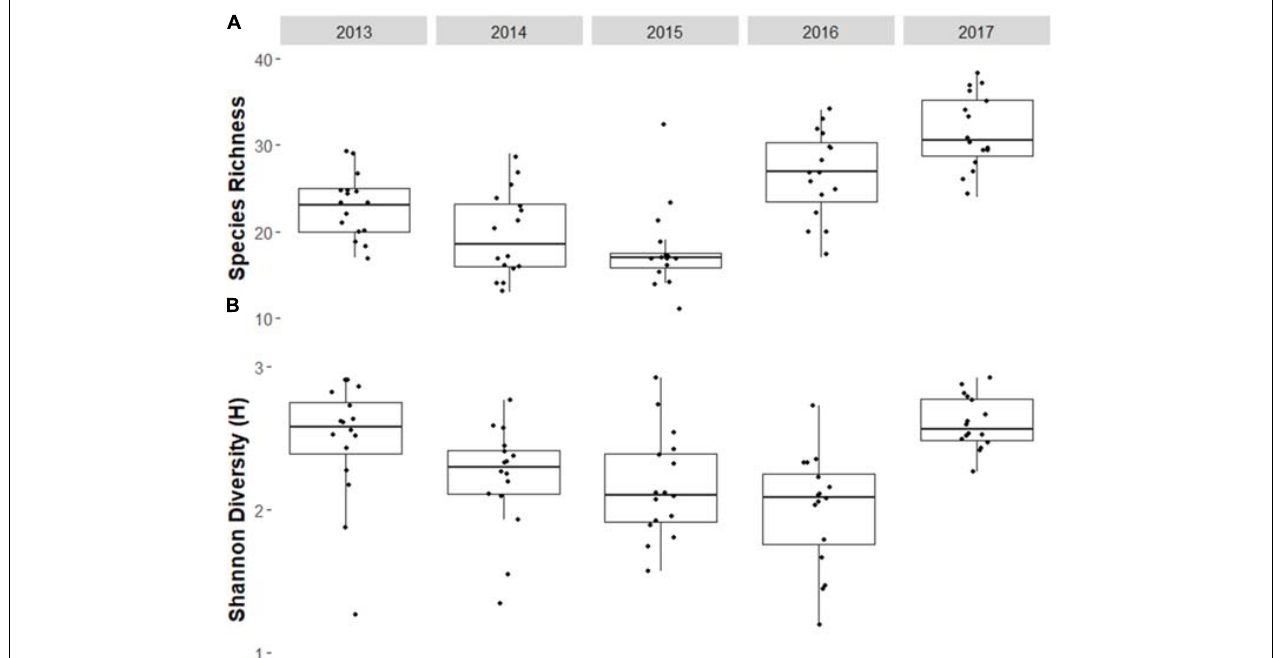
FIGURE 6 | Box and whiskers plot of (A) Species richness per transect, (B) and Shannon Diversity Index per transect around the Hui Feng wreck site. The wreck was removed between the 2013 and 2014 surveys.